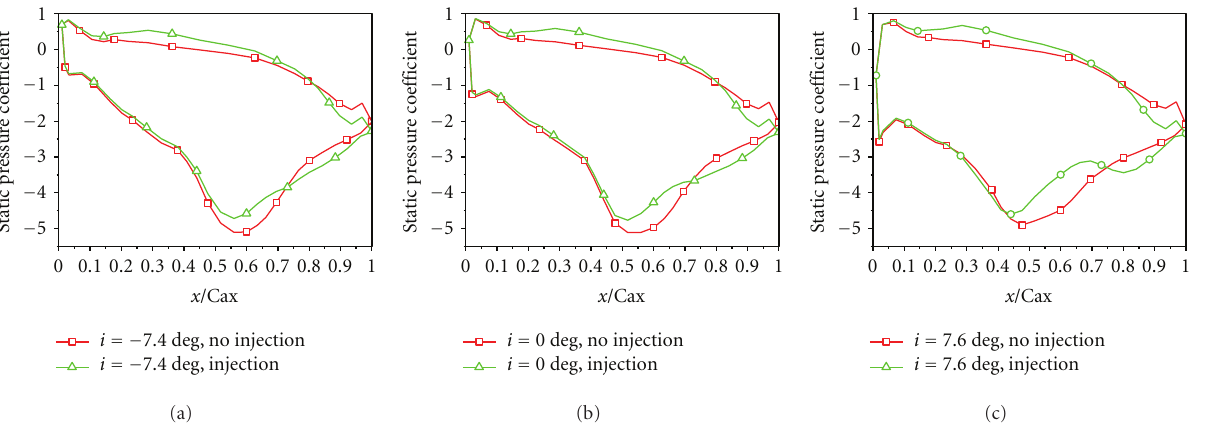
Figure 3: Distributions of static pressure coe ffi cient ( C p ) at 98% span (a) i = − 7 . 4 ◦ , (b) i = 0 ◦ , (c) i = 7 . 6 ◦